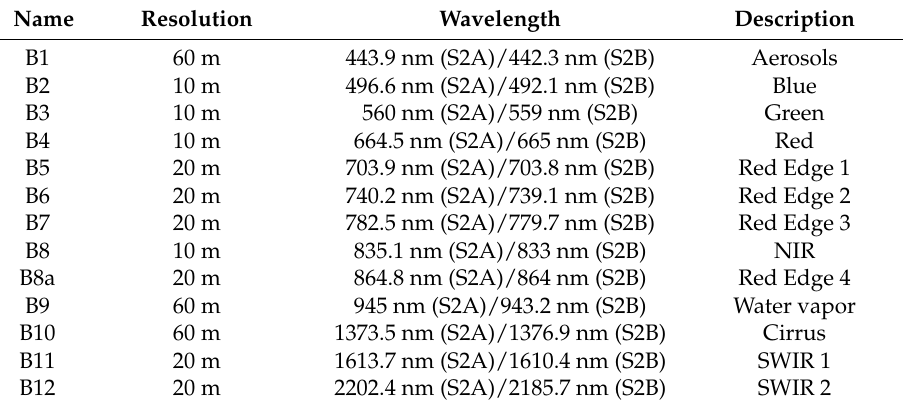
Table 2. Spectral bands in